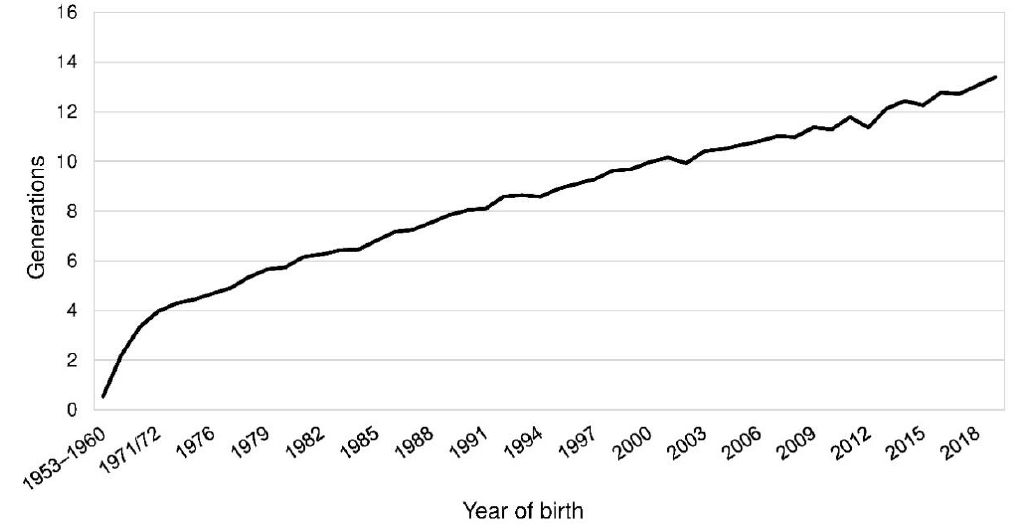
Figure 1. Mean equivalent complete generations by birth years of Polish Lowland Sheepdogs (PONs). The mean equivalent complete generations across all 8628 PONs was 8.73 generations.